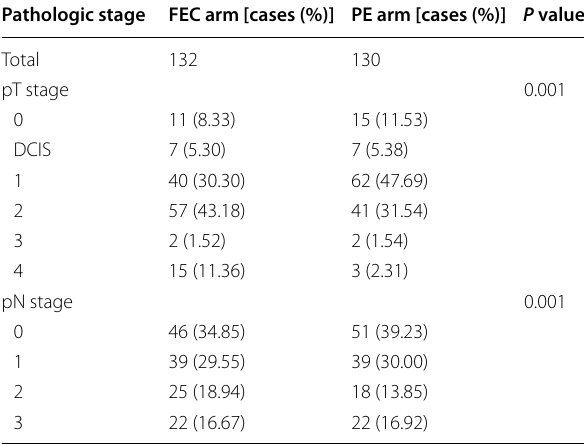
Table 5 Postoperative pathologic staging in patients who underwent surgery